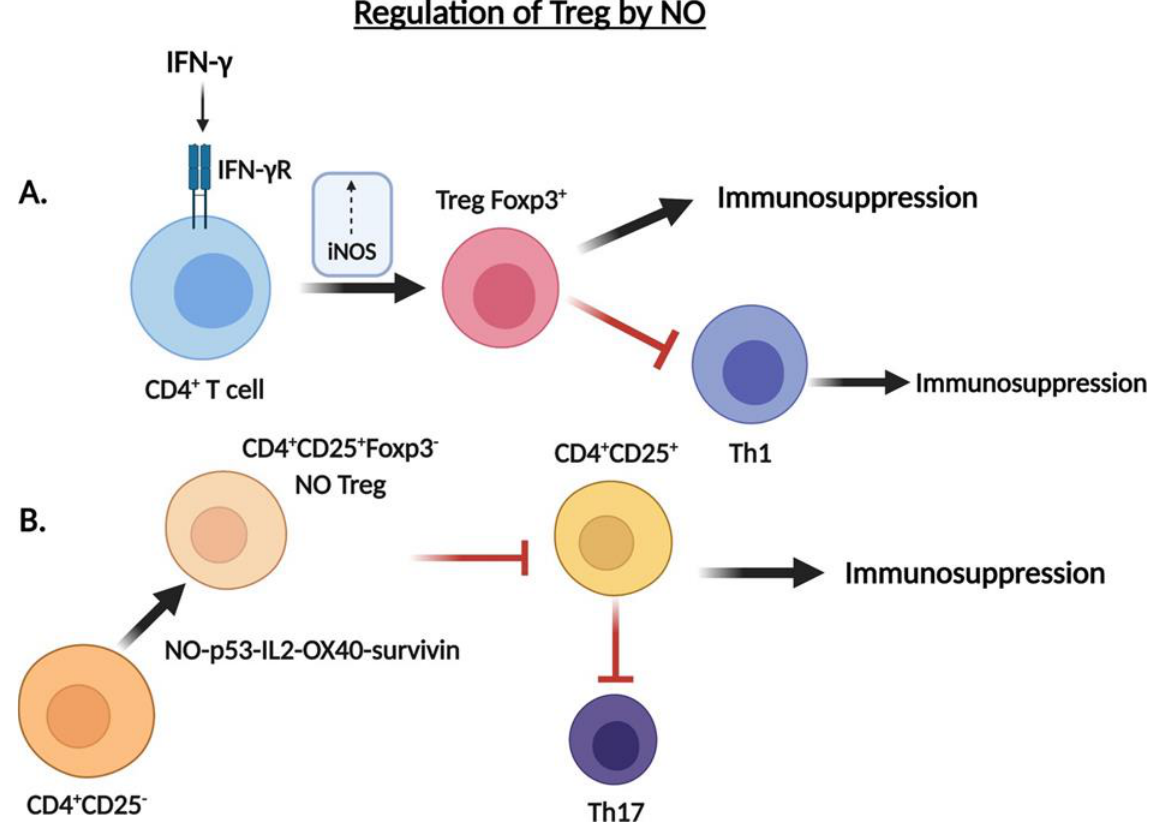
Figure 3. Regulation of Tregs by .NO. ( A ) IFN- γ induces a population of Foxp3+ Tregs in an iNOS-dependent pathway to exert its immunosuppressive role in the TME. ( B ) The emergence of CD4 + CD25 + Foxp3 − .NO Tregs is a result of the conver- sion of CD4 + CD25 − T cells via a .NO- p53-IL2-OX40-survivin signaling pathway. .NO-Tregs serve an immunoregulatory role via suppression of .NO-mediated activation of Th17 cells during infection.